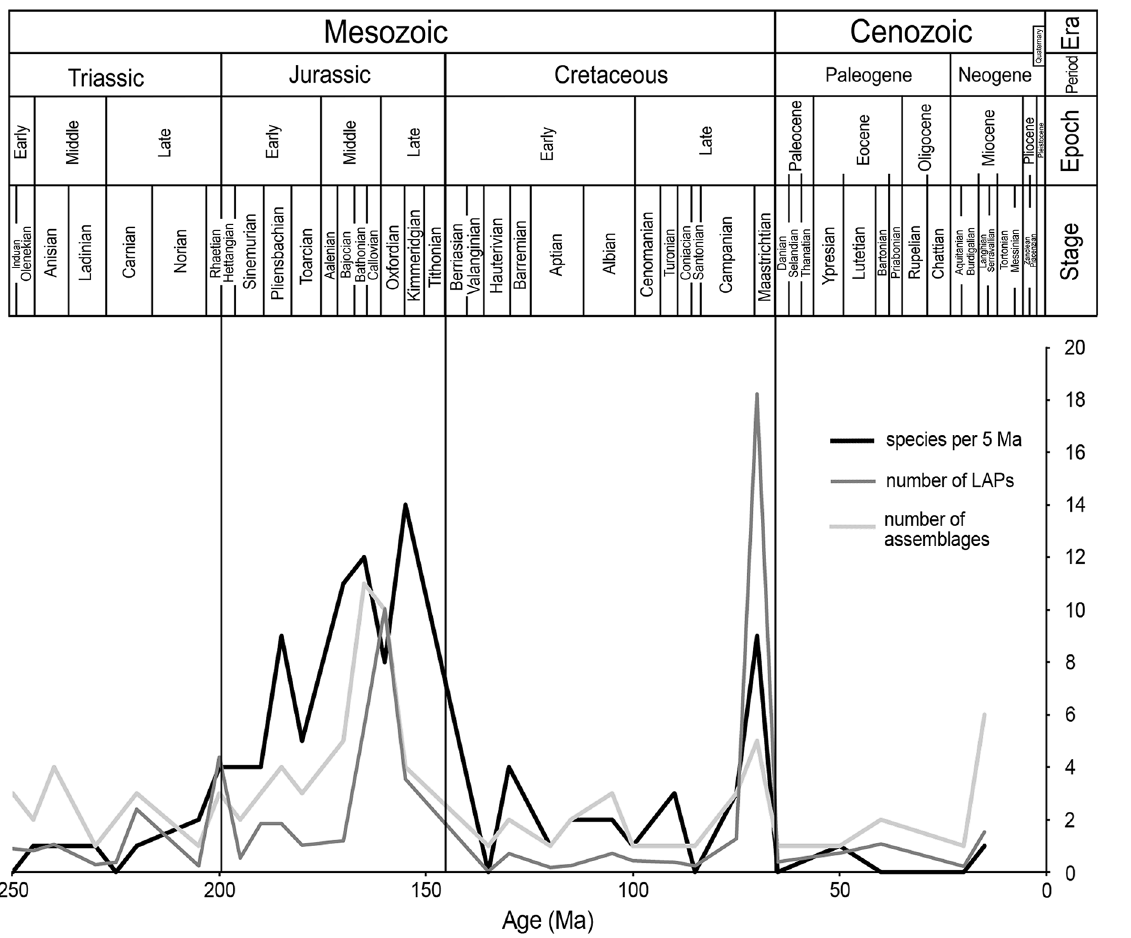
Fig. 5. Diversity of ophiacanthid brittle stars, given as species richness per 5 Ma intervals, in shallow- water (< 200 m palaeodepth) environments through time, together with corresponding numbers of samples and of lateral arm plates (LAPs) counted (both ophiacanthids and non-ophiacanthids) per interval. Note that the scale for specimen numbers is increased by factor 10 3